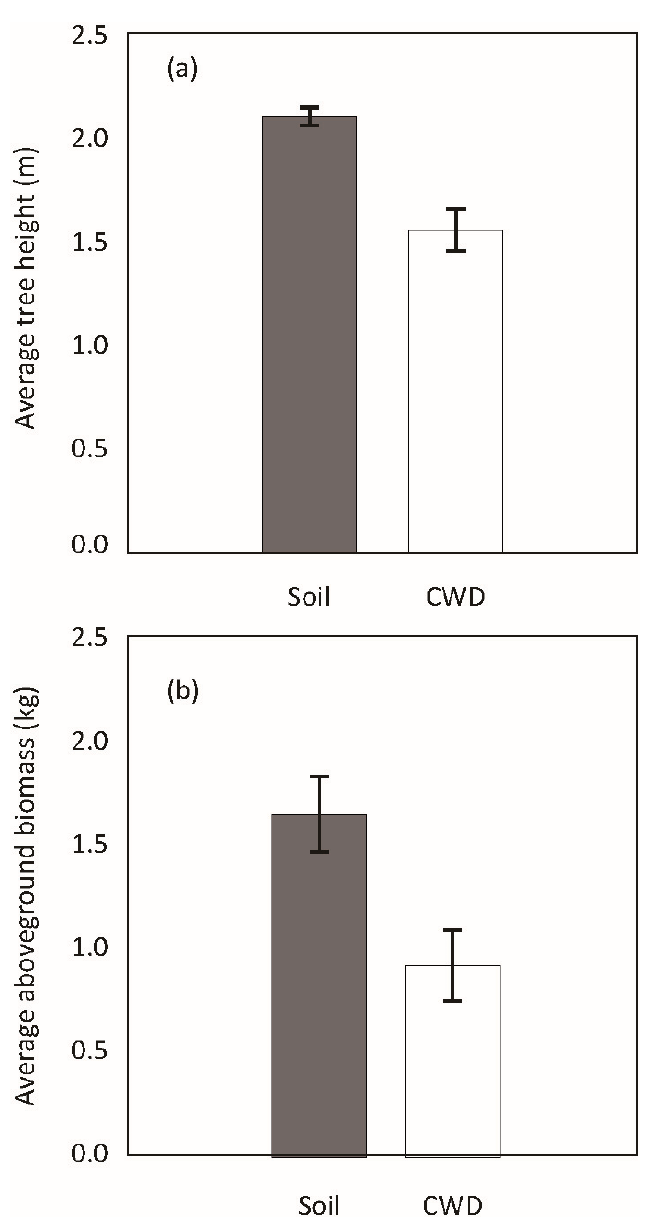
Figure 7. Mean height ( a ) and mean aboveground biomass per tree ( b ) for individuals growing on two different substrates, i.e., soil versus coarse woody debris (CWD)—results for salvaged and unsalvaged plots together (the High Tatra Mts. in 2019). Differences were tested with an LSD test and showed significant differences for tree height ( p < 0.001) as well as for aboveground biomass ( p < 0.001). Error bars show standard errors.